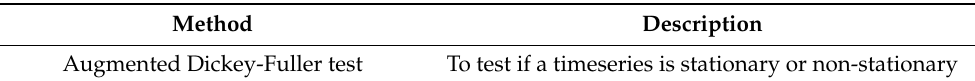
Table 5. Hypothesis testing method